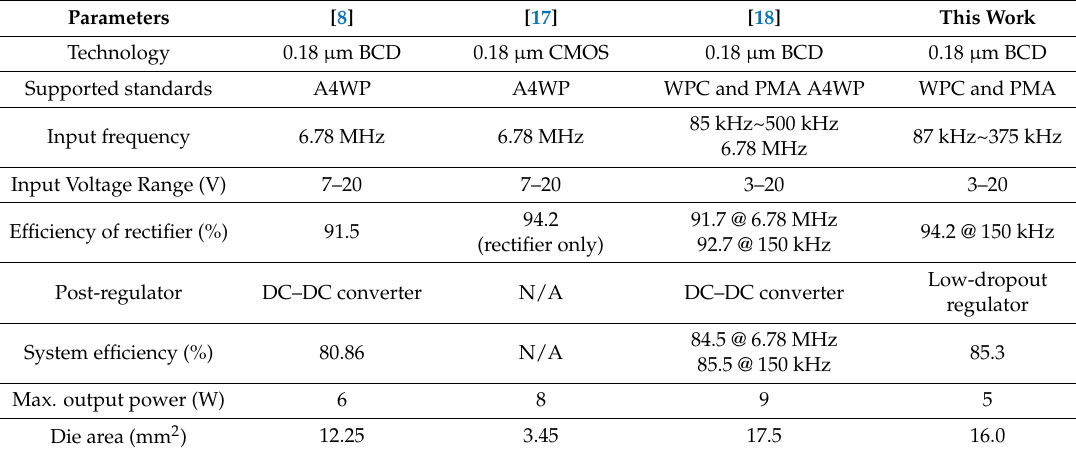
Figure 14. Measured PCE of the active rectifier and wireless power receiver. Table 1. Performance comparison with prior works